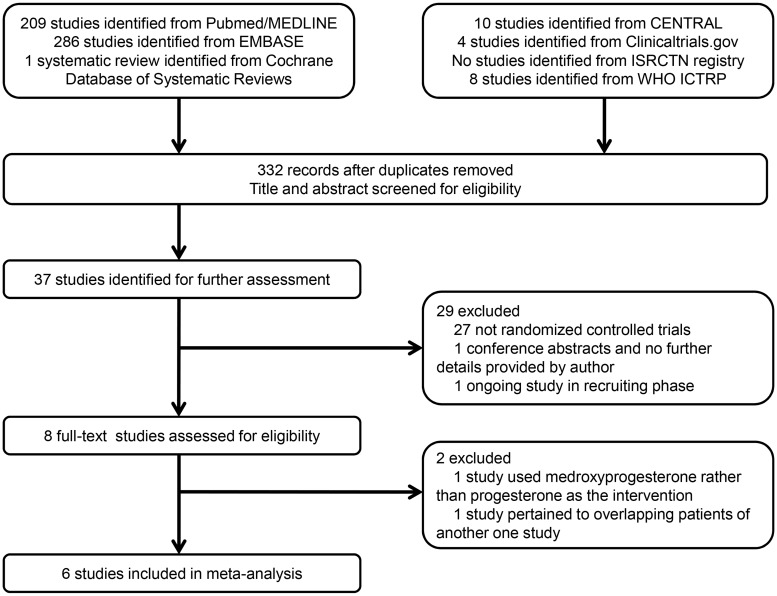
Flow diagram showing selection of studies.